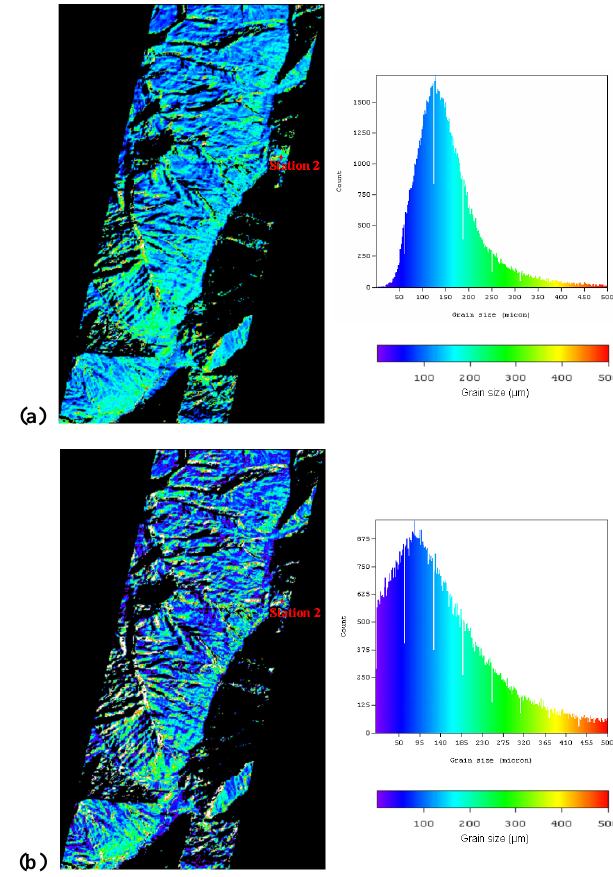
Fig. 7. The spatial distribution of snow grain size retrieved using (a) 1240nm and (b) 1050nm by Hyperion data for a part of middle